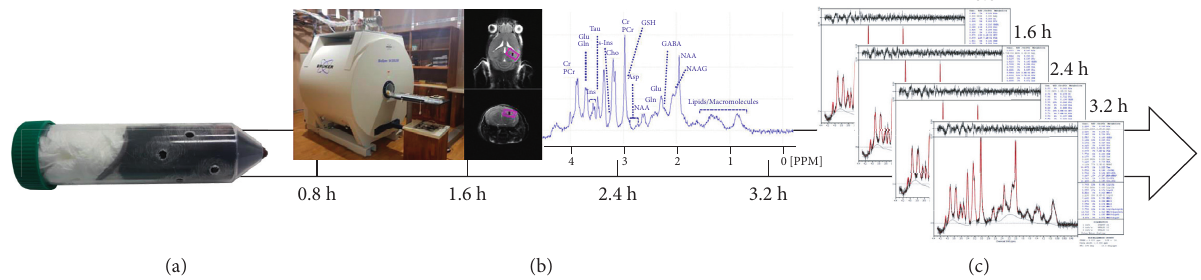
Figure 1: A flowchart of 1 H-MRS data analysis: from data acquisition to metabolite quantification. (a) Mouse in the stress group was exposed to acute restraint stress physically for 2 hours in a transparent 50mL conical tube. (b) 1 H-MRS data in the hippocampus were collected at 4 consecutive time points using 9.4T Bruker MRI. (c) Metabolites were quantified using the linear combination analysis method (LCModel) in four time